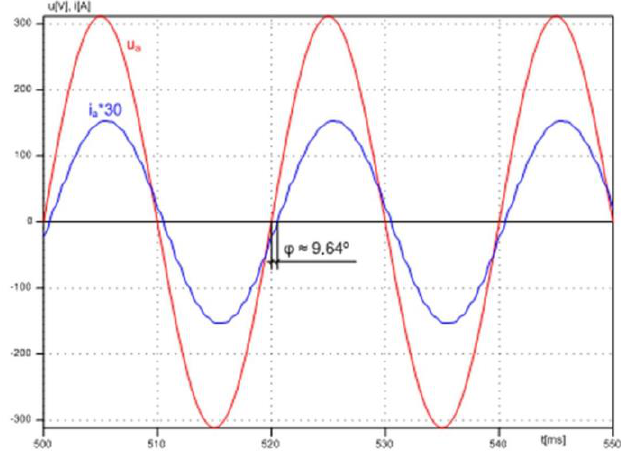
Figure 17. Waveforms of line voltage u a and current i a.